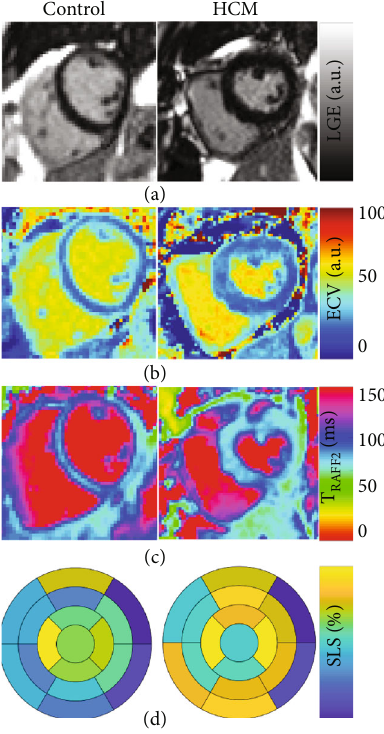
Figure 1: Late gadolinium enhanced image LGE (a), extra cellular volume map ECV (b), RAFF2 relaxation time T segmental longitudinal strain (d) showing one case of HTN LVH patients and one from control group using 17-Segment Model